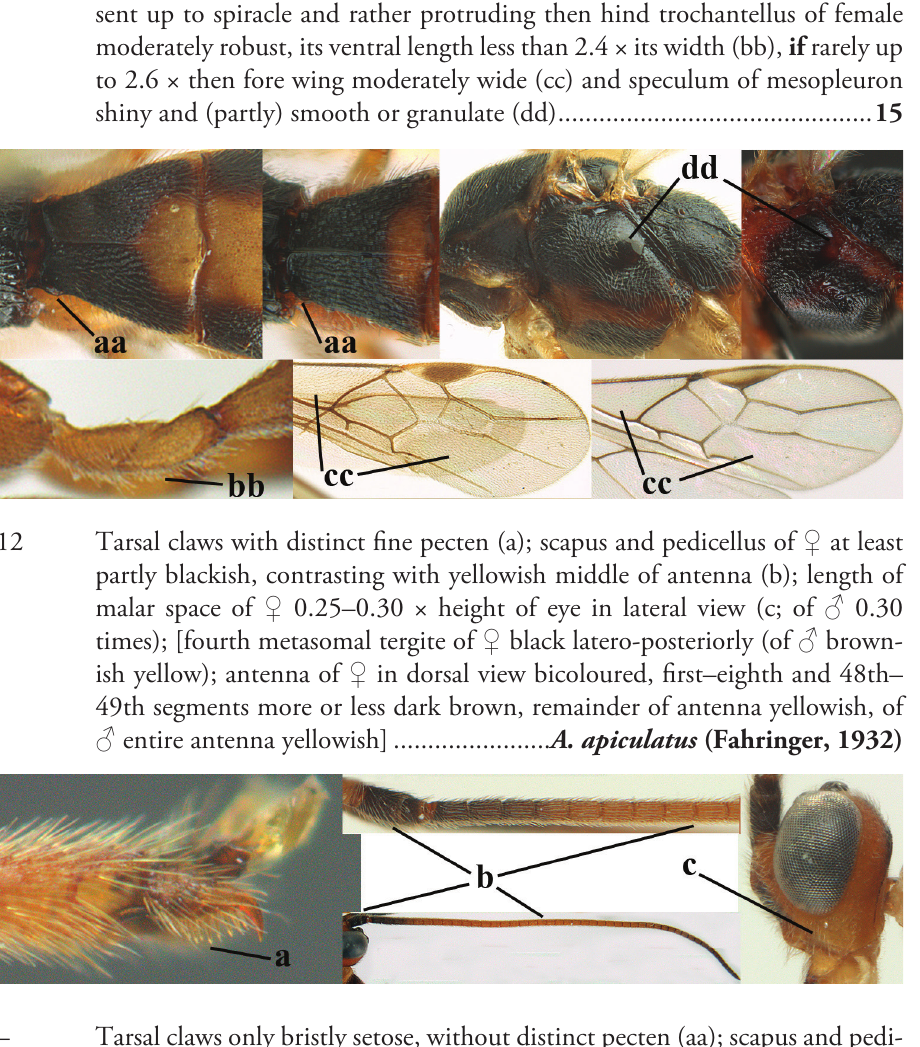
– cellus of ♀ similarly coloured as medial fifth of antenna or paler (bb);